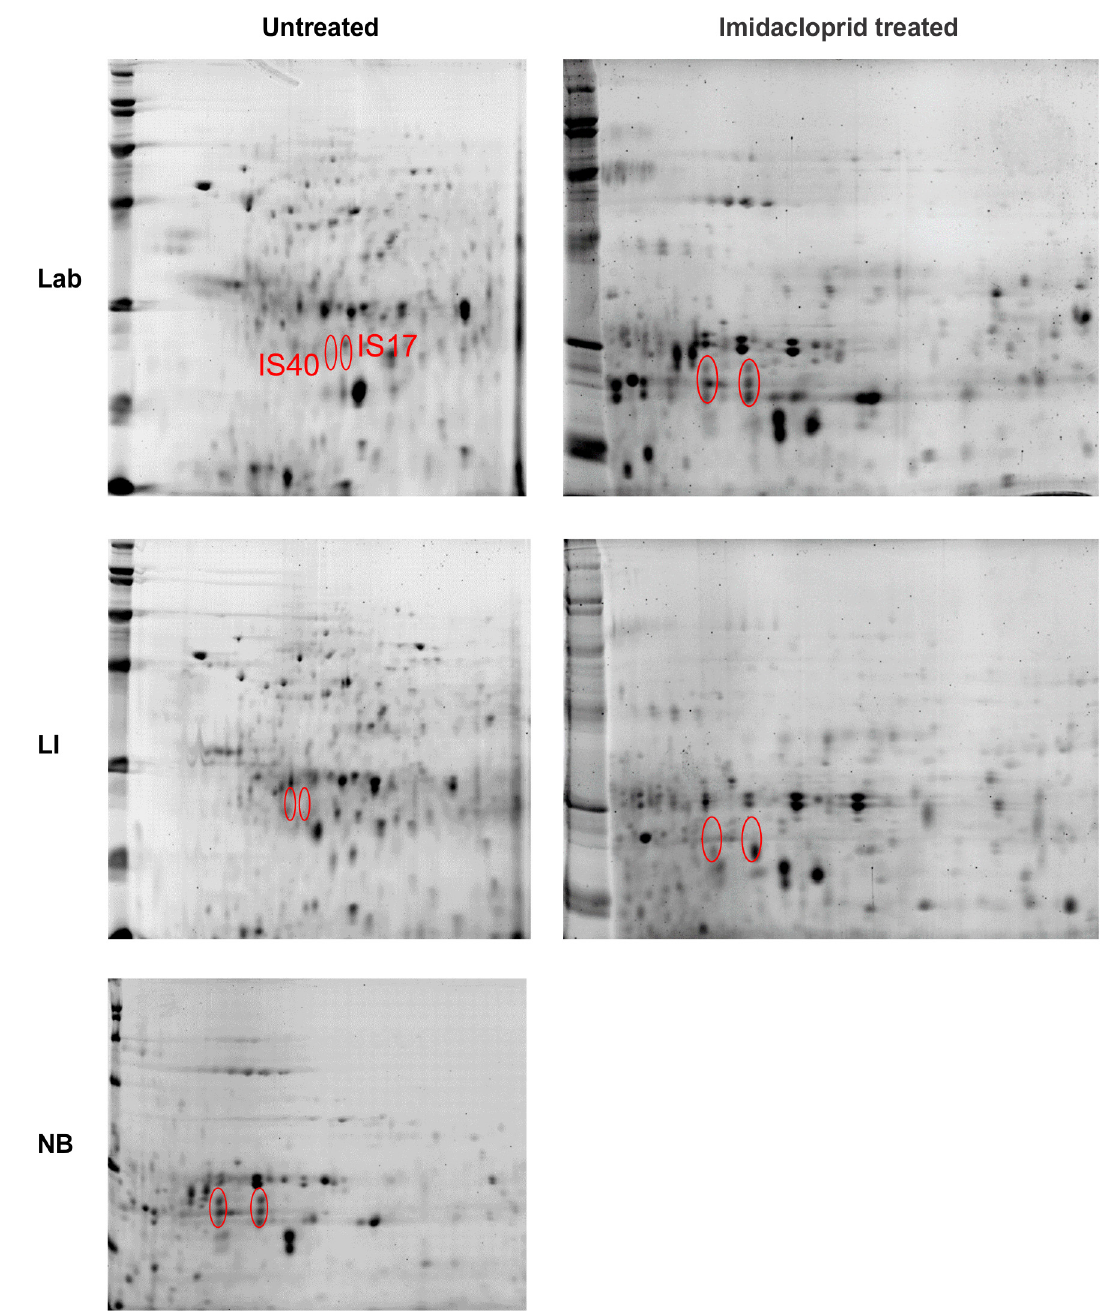
Figure 5. 2D PAGE gel separations of adult Colorado potato beetle midgut tissue proteins from insecticide susceptible (Lab), resistant (LI) and tolerant (NB) strains. Strips 13 cm in length were run at pH 4–7 and cut to 7 cm. The location of two high concentration protein spots (IS17 and IS40) in the tolerant strain (NB) was marked in the gels for each strain, either pre-treated with imidacloprid or untreated.